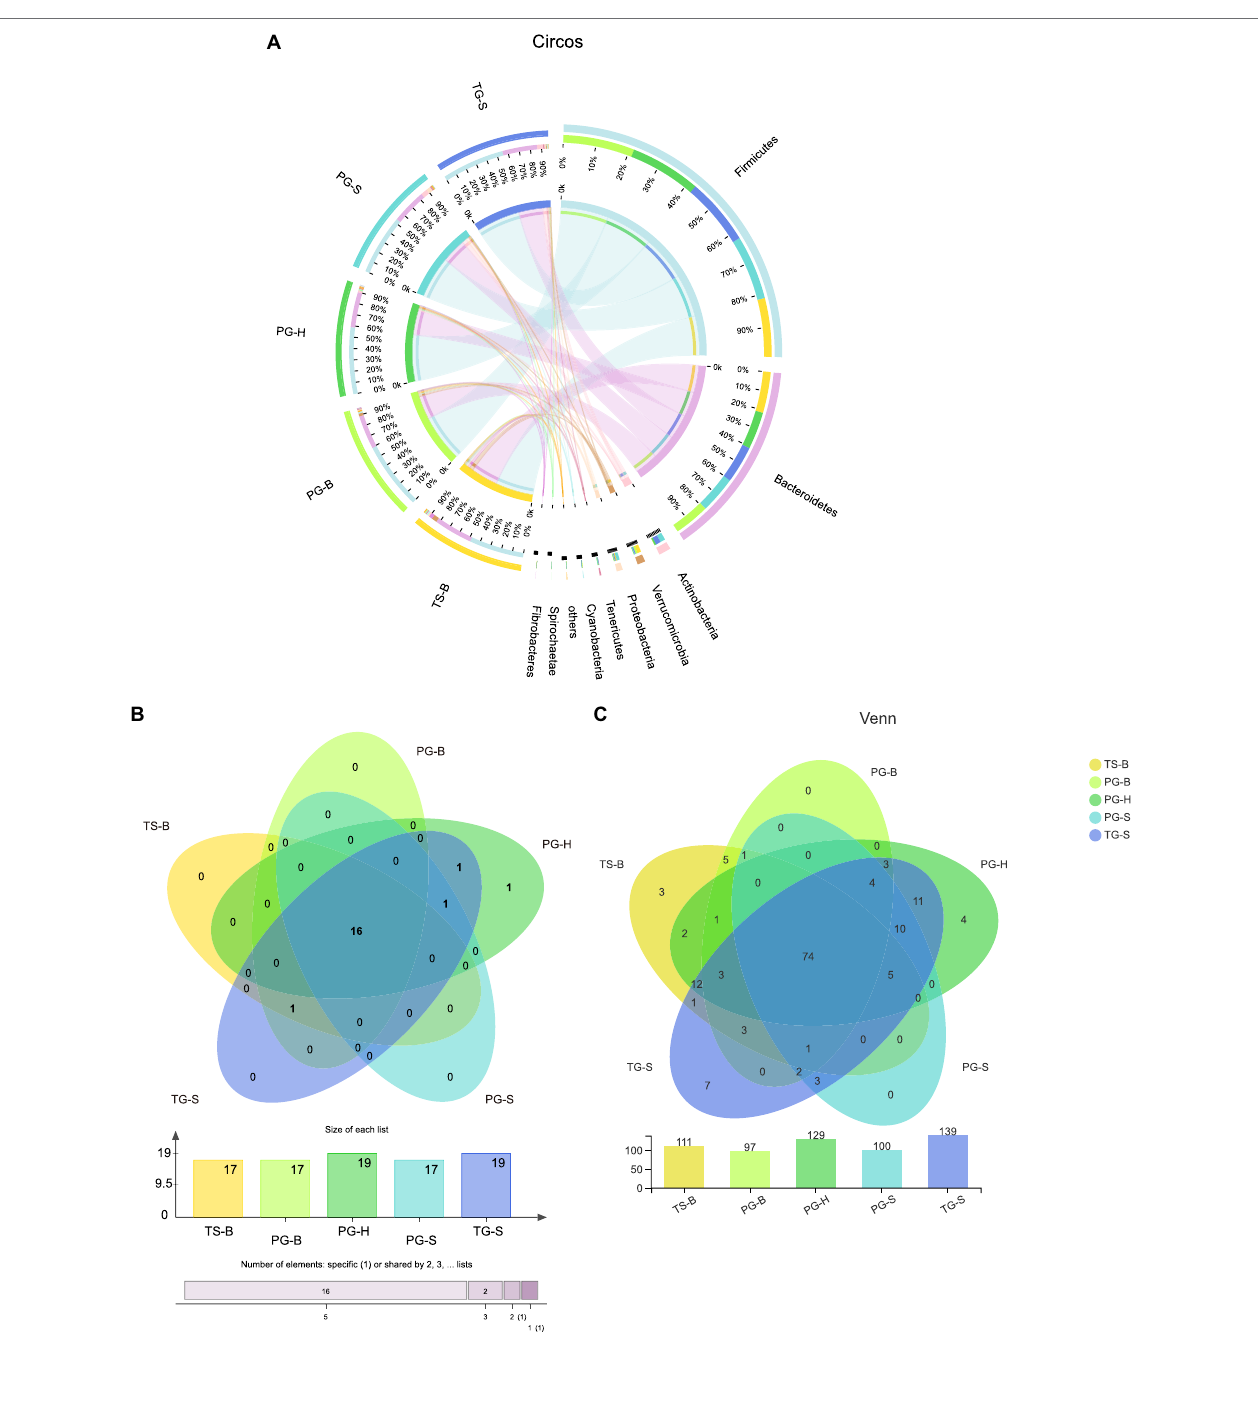
FIGURE 3 | (A) Proportion of dominant species in each sample. The outer circle segments of left half indicate different populations, the inner circle of left half indicate bacterial phyla and their abundance in each population. The outer circle segments of right half indicate different phyla and the length of each segment represents the abundance of the phyla. The width of a chord represents the abundance of a phylum in a population. (B) Shared and unique phyla of the five populations of the three ruminants. (C) Shared and unique families of the five populations of the three